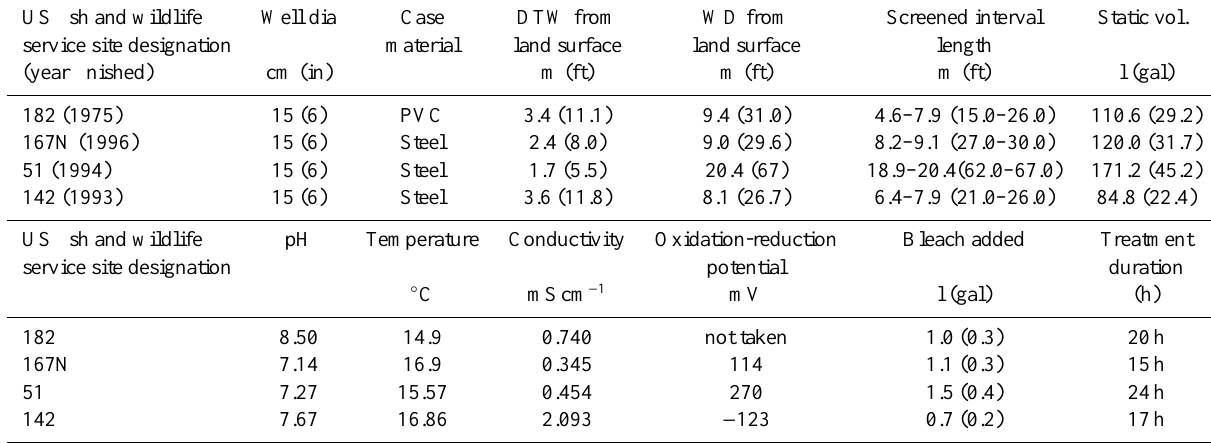
Table 1. Well characteristics and water physical and chemical characteristics immediately prior to shock chlorination; DTW is depth to water from the land surface, WD is total depth of the well, Static vol. refers to the standing volume of water in a well after water level recovery following the end of pumping. The measurements reported are also referred to as IP (Initial Purge) in Table 4. Initial Purge refers to purging prior to treatment, to replace water stored in the casing with water from the surrounding saturated formations. Well diameter, case material, depth to water from the land surface and well depth were recorded at each site. The screened interval length was obtained from well logs available on the Nevada Division of Water Resources (http: // water.nv.gov / , last accessed April